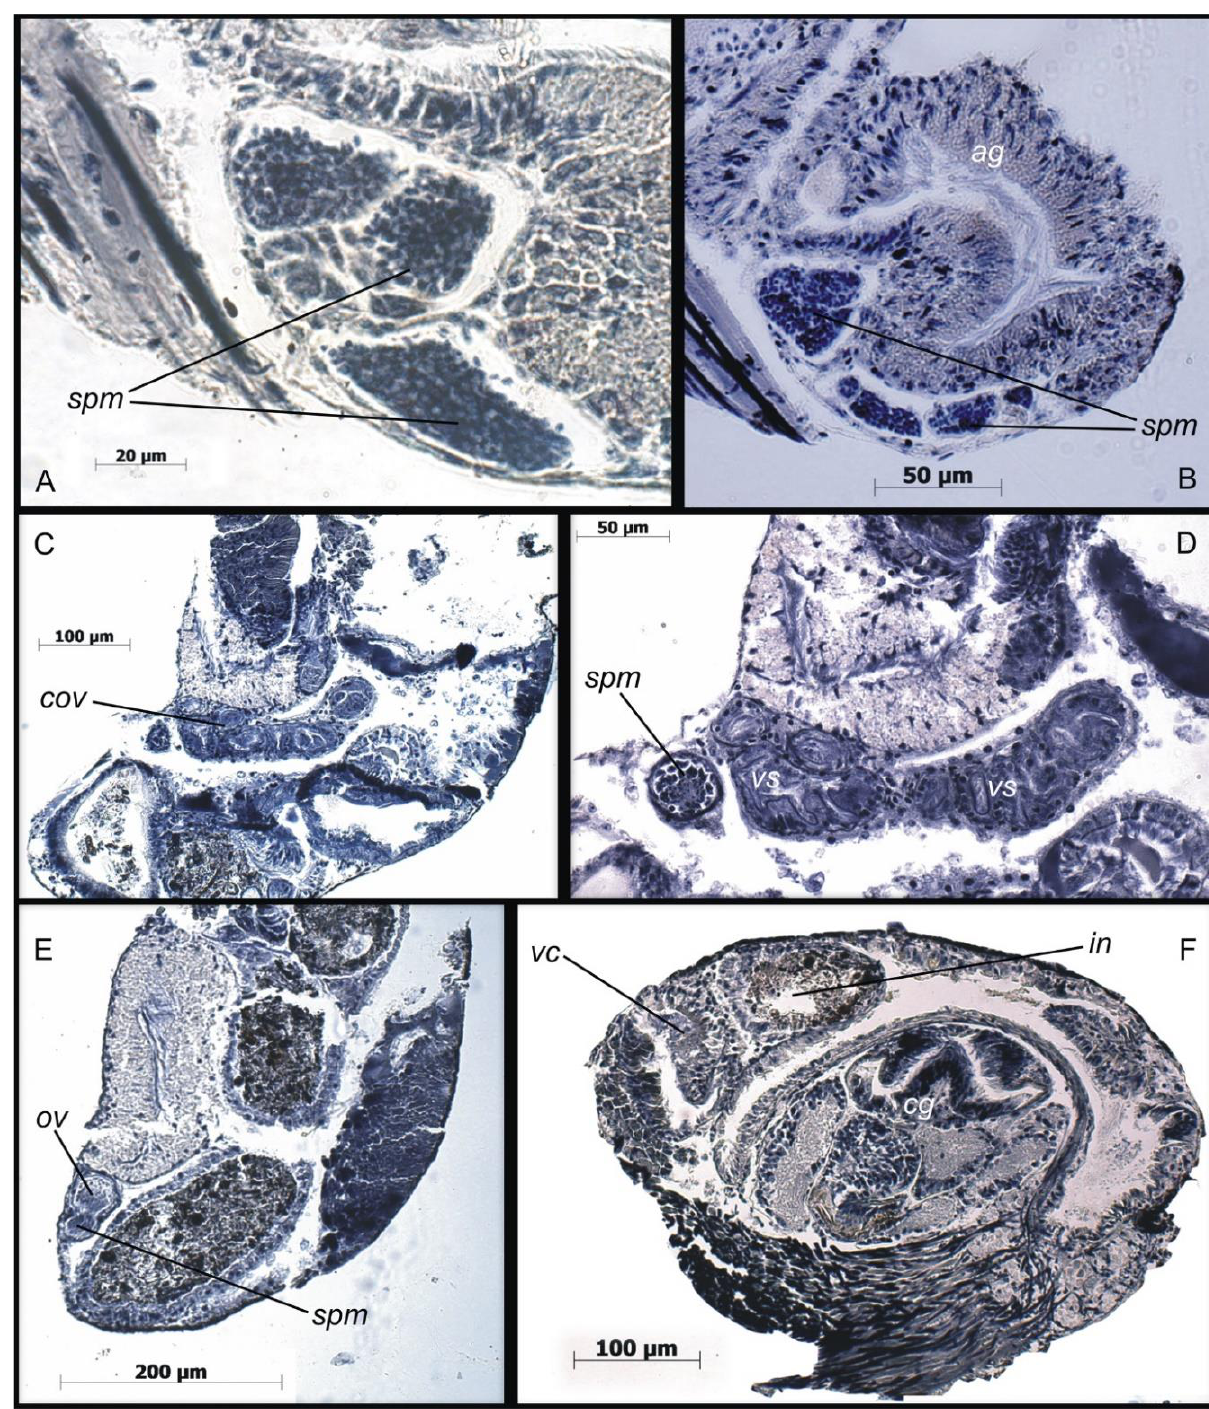
Figure 11. Histological sections of the female reproductive system of C. laevigata sp. n. (individual from the locality Dag28): ( A , B ) — sections a-a and b-b across two adjacent areas of spermatheca and albumen gland; ( С , D ) — section c-c across coiled renal loop and spermatheca; ( E ) — section d-d across oviduct and spermathecal duct; ( F ) — section e-e across capsule gland, ventral channel, and intestine. Abbreviations: in — intestine; ov — oviduct; vs — vesicles; other abbreviations as in Figure 10. The operculum of the studied individuals (Figure 6N,O) is flat, thin, transparent, a little smaller than the aperture, ovate, and paucispiral with about 15 axial growth lines and a subcentral nucleus. The muscle attachment area edges are clearly